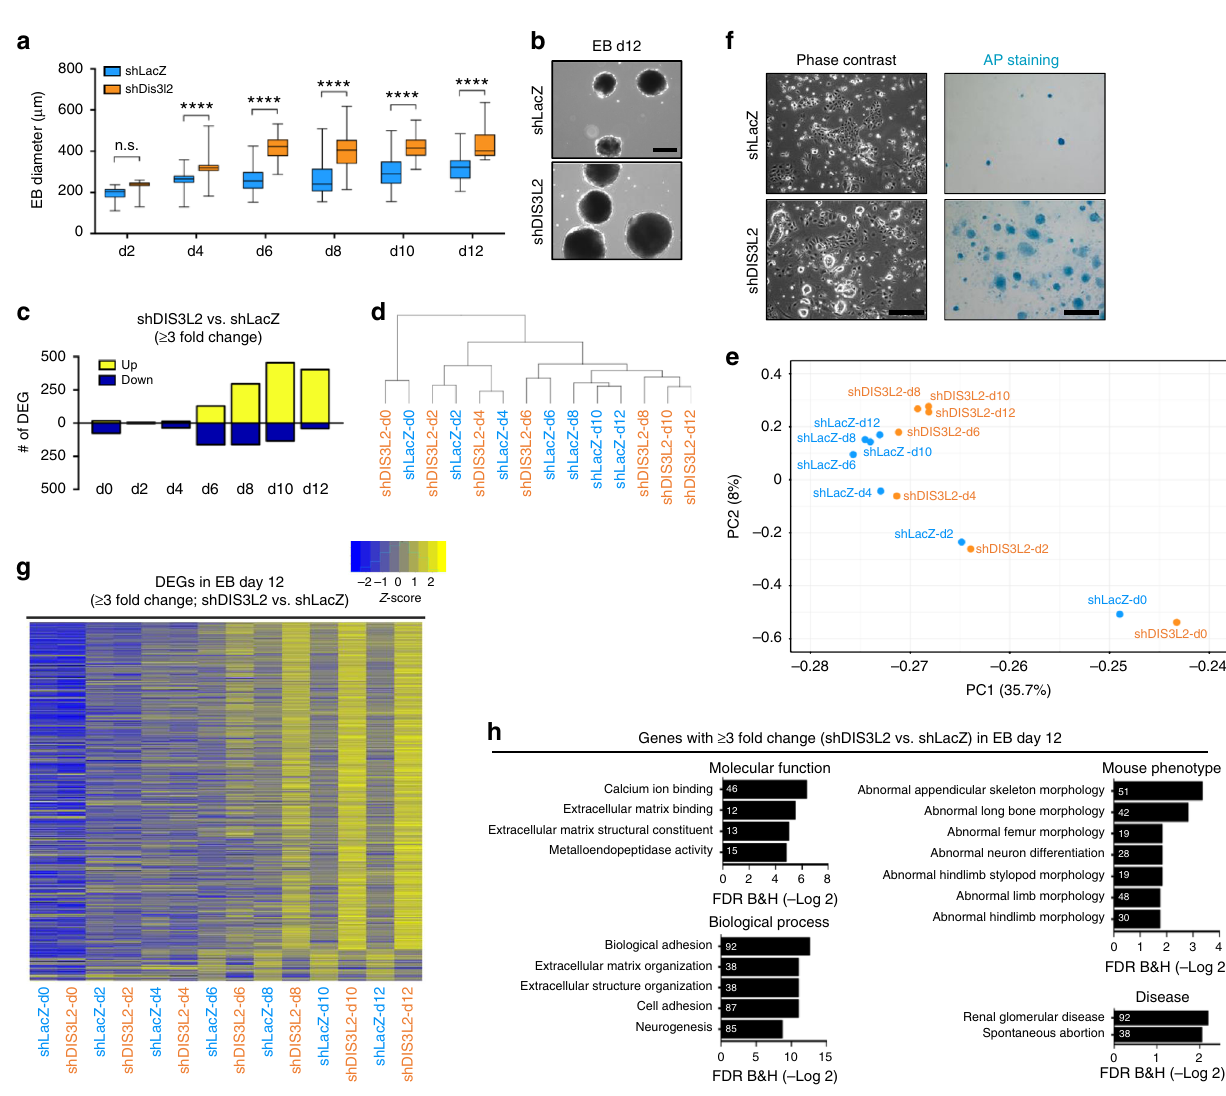
Fig. 5 Impaired in vitro differentiation upon DIS3L2 loss. a The size of EBs during in vitro spontaneous differentiation. Minimum, maximum, median, and boxes extending from the 25th to 75th percentiles are shown ( n = at least 30 EBs measured). b Representative images of EBs at d12. This experiment was repeated twice independently with similar results. Scale bar = 200 μ m. c The number of differentially expressed genes (DEGs) during spontaneous differentiation of EBs. Hierarchical clustering ( d ) and PCA analysis ( e ) of mRNA sequencing data are shown. f Phase contrast (left panels) and AP staining (right panels) of d12 differentiated cells replated for 5 days in the presence of LIF and serum to support ESC colonization. This experiment was repeated twice independently with similar results. Scale bar = 200 μ m. g Heatmap representation of differentially expressed genes at d12 during the entire course of differentiation. h Gene ontology analysis of DEGs from g at d12 of differentiation; numbers inside the bars indicate the number of DEGs associated with each biological